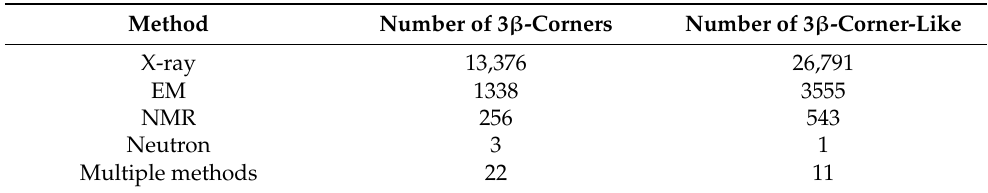
Table 2. Methods of protein 3D-structure determination experiments used to recognize and segment 3 β - corners and 3 β -corner-like structures.